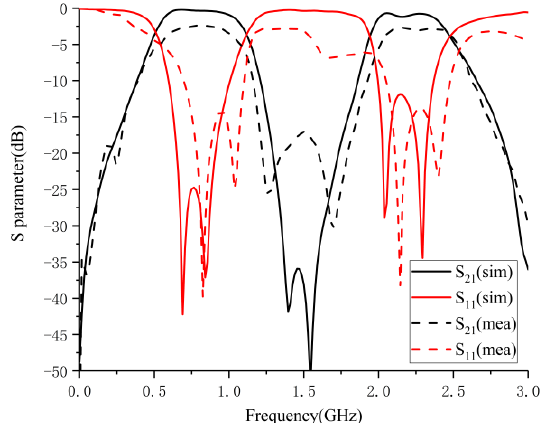
Figure 10. Simulated and measured S-parameters of the broad dual-band bandpass filter: 0–3 GHz.